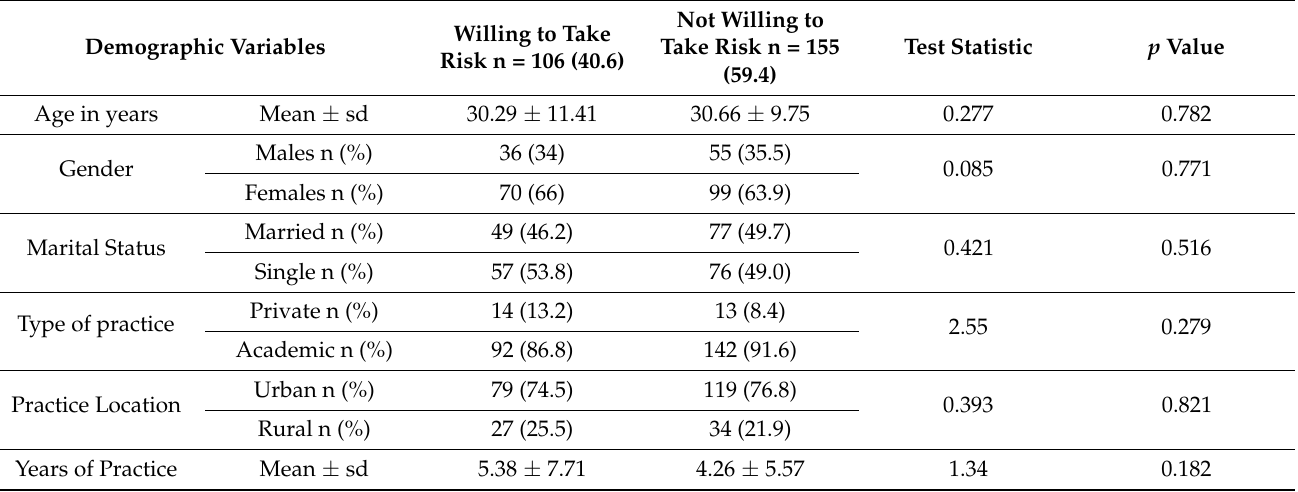
Table 10. Bivariate analysis of demographic variables vs. willingness to take risk using chi-squared test for independence of attributes.